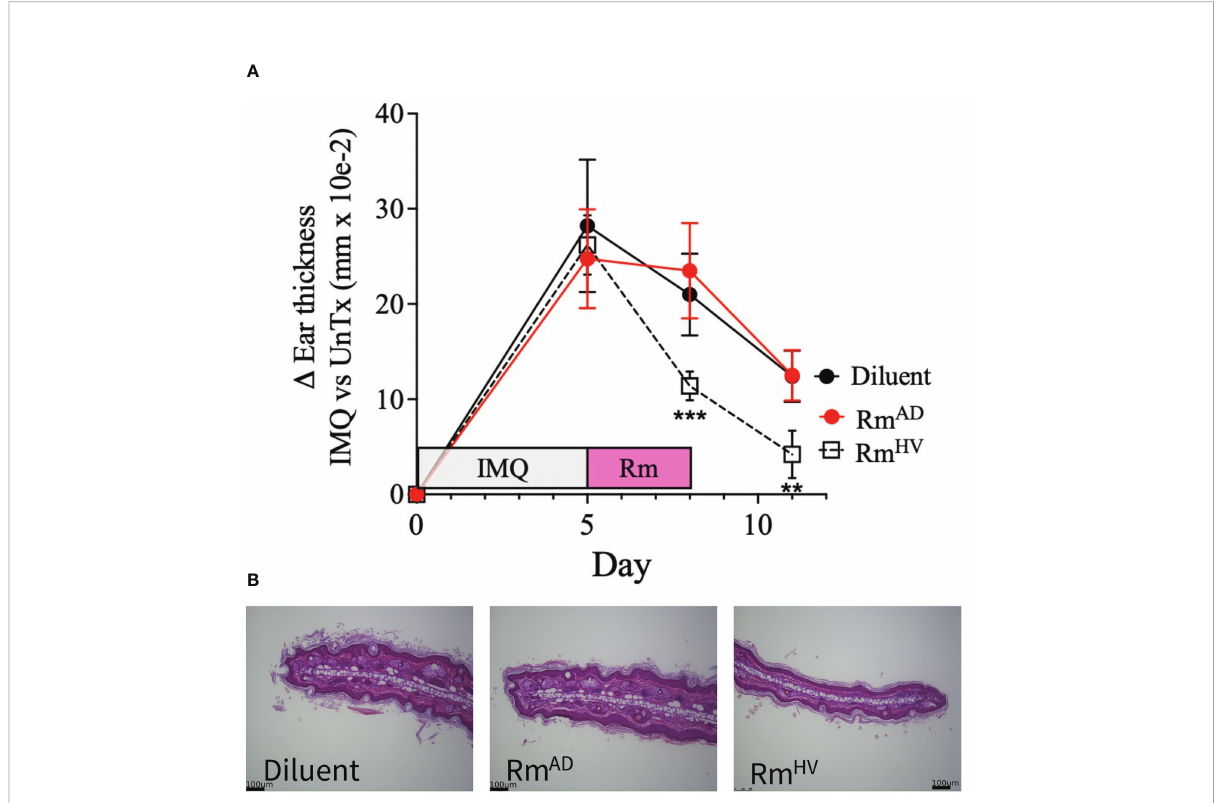
FIGURE 2 Topical R. muocsa improves mouse models of psoriasis. Mice (N = 5 per group) were treated with imiquimod (IMQ) daily for 5 days on one ears before topical treatment with 10 6 colony forming units of R. mucosa from a healthy volunteer (Rm HV ), a patients with atopic dermatitis (Rm AD ), or diluent control were applied with the same ear for 3 days. (A) Differences between the unperturbed and treated ear are shown. (B) Representative images for one treated ear from each group are shown. Black bars indicate 100um scale. Data represent two independent experiments and displayed as mean ± SEM. ***p<0.001,